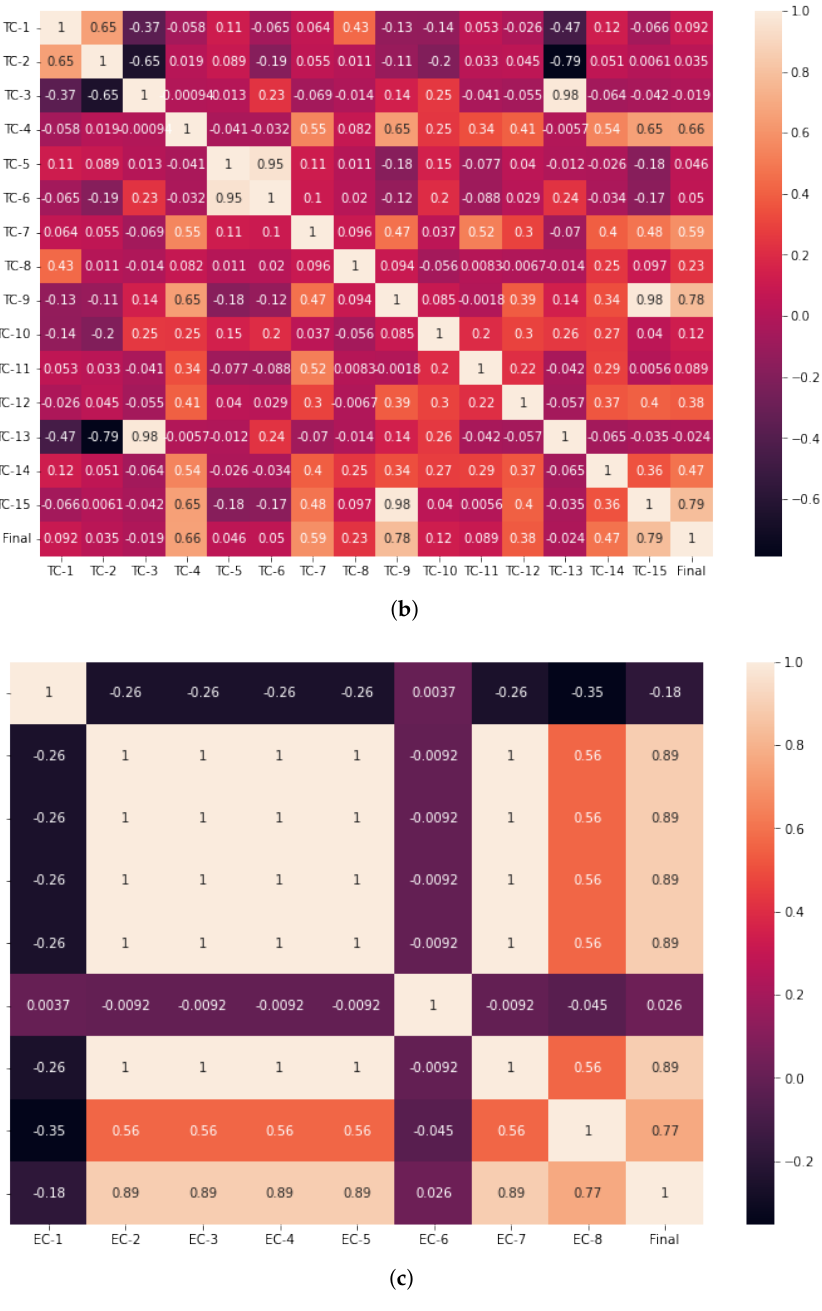
Figure 5. Correlation graphs—dependent and independent variable selection. ( a ) Academic criteria correlation. ( b ) Technical criteria correlation. ( c ) Examination criteria